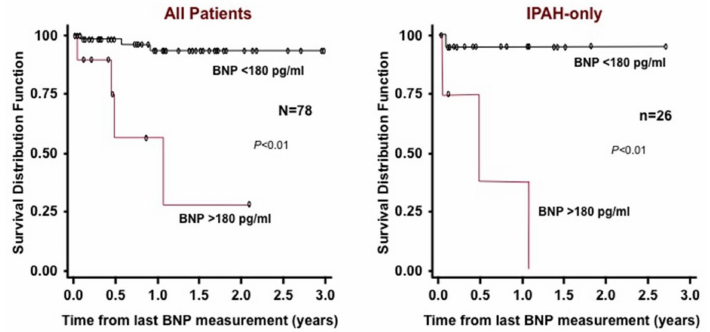
Figure 9. Kaplan–Meier survival curves for children with IPAH and PAH associated with CHD. Survival curves are shown for all patients ( left ) and for the subgroup of IPAH patients ( right ) categorized with either brain natriuretic peptide (BNP) > 180 pg/mL or < 180 pg/mL